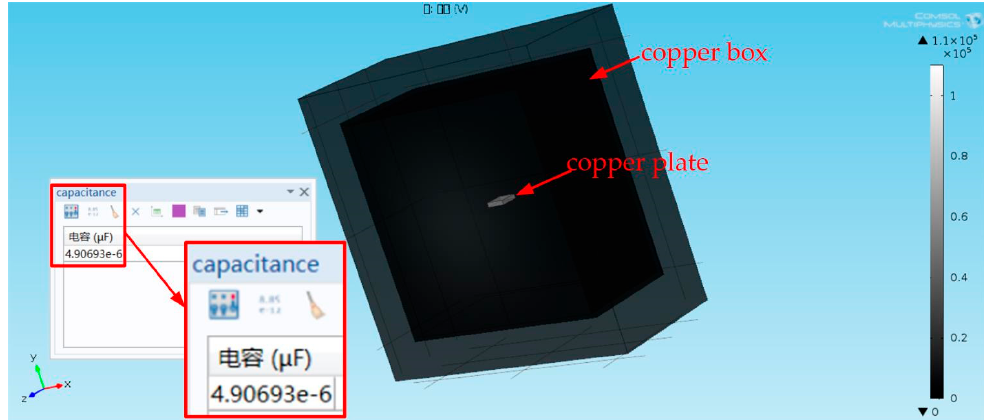
Figure 7. COMSOL Multiphysics simulation of self ‐ made capacitor.